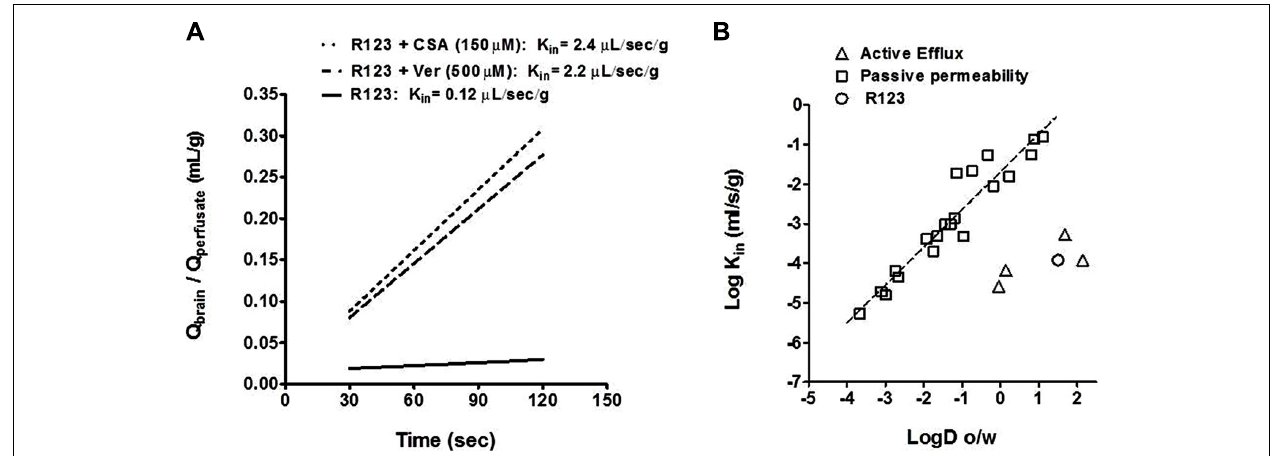
FIGURE 2 | (A) The K in of R123 in the presence of the known P-gp inhibitors, cyclosporin A and verapamil, increases brain distribution (as reported by the K in ) by > 10-fold. All data represent mean ± S.E.M for total brain; n = 3–5 for all groups. Statistics: one-way ANOVA; Dunnett’s. (B) The relationship between LogD (octanol/water coefficient; pH = 7.4) and observed K in is used